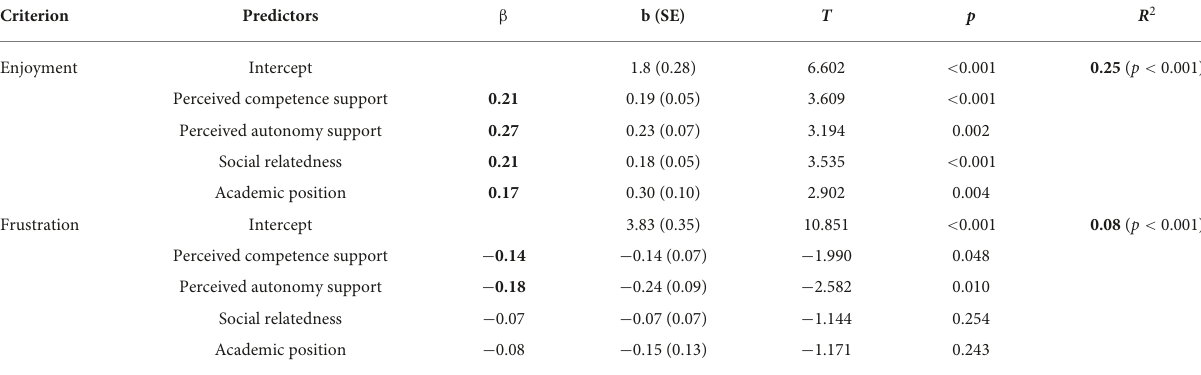
TABLE 3 Results of multiple linear regressions predicting researcher’s activity-related achievement emotions (enjoyment and frustration) by perceived competence support, autonomy support, social relatedness, and the academic position ( N = 250).